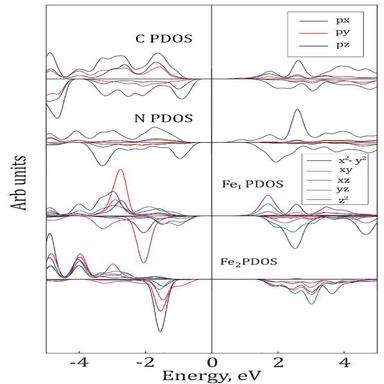
Orbital resolved PDOSes of (Fe2)@g-CN1 calculated at GGA/HSE level of theory.